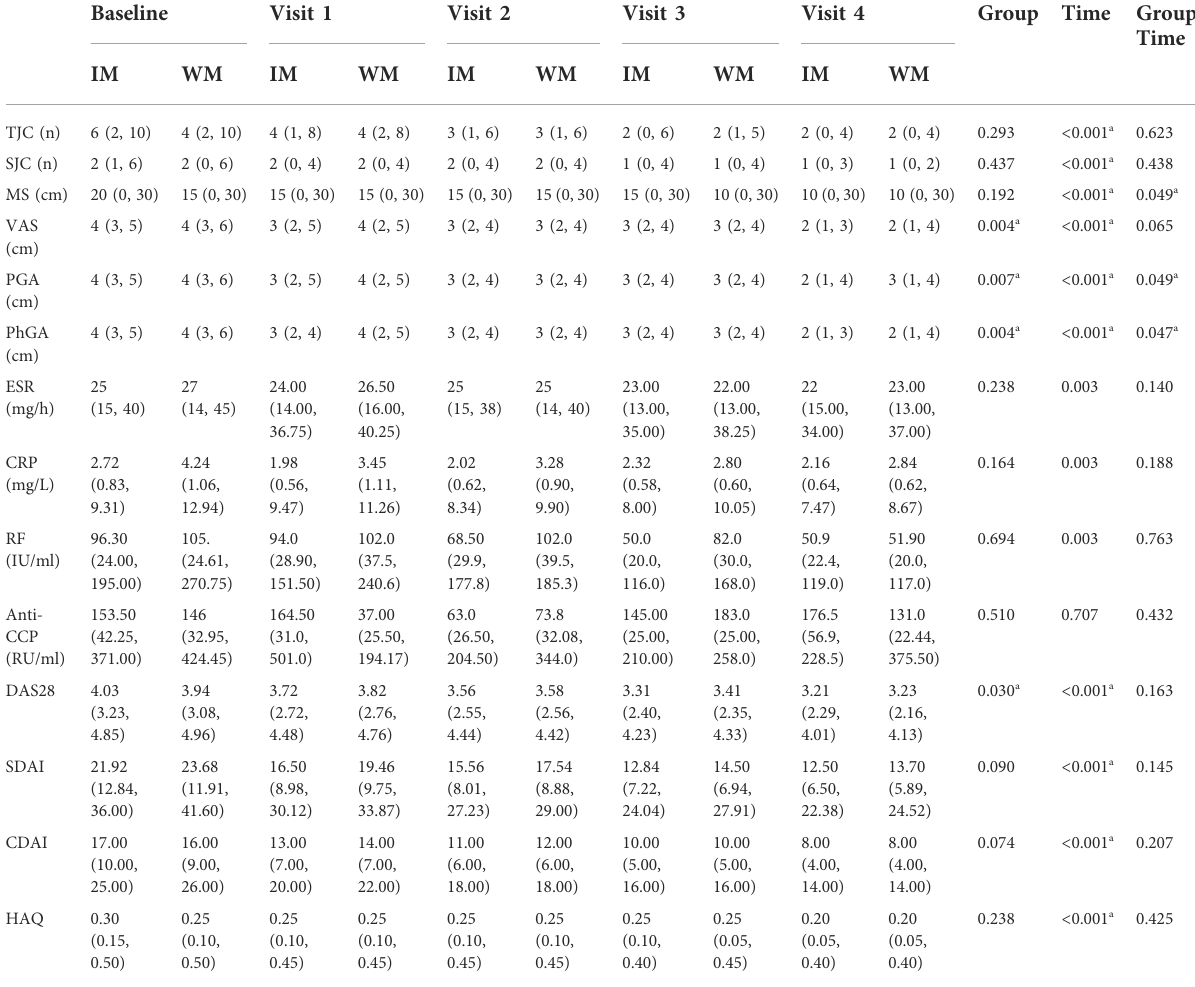
TABLE 3 Change in different rheumatoid arthritis clinical manifestations at different visits in PP population, median (IQR) unless otherwise stated. Baseline Visit 1 Visit 2 Visit 3 Visit 4 Group Time Group: